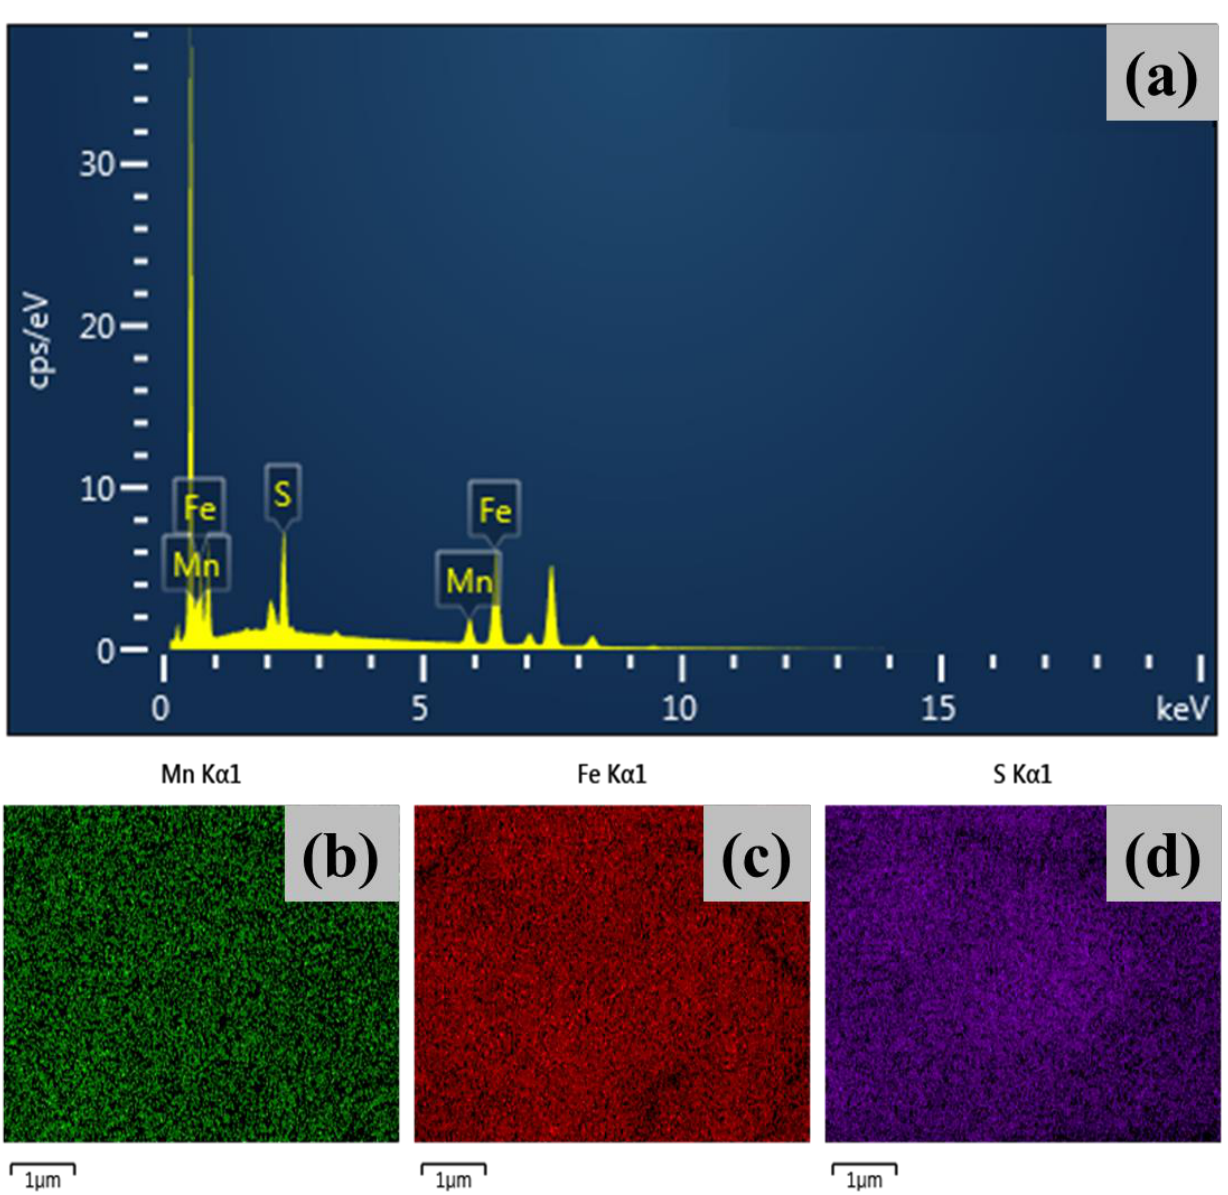
Figure 3. Elemental analysis of MFS-15 sample ( a ) energy dispersive spectroscopy (EDS) graph, elemental mapping analysis of ( b ) Mn Kα1, ( c ) Fe Kα1, and ( d ) S Kα1.